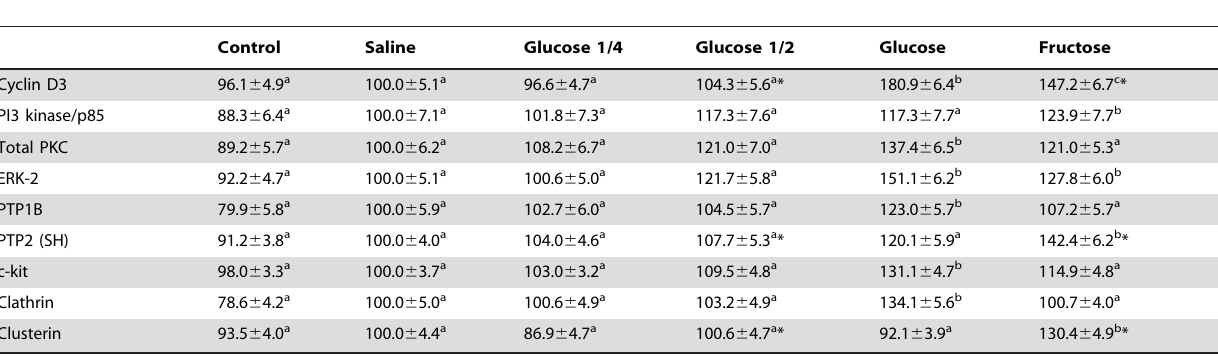
Table 2. Relative increase in serine phosphorylation levels of selected liver proteins in rats subjected to either an oral glucose or fructose